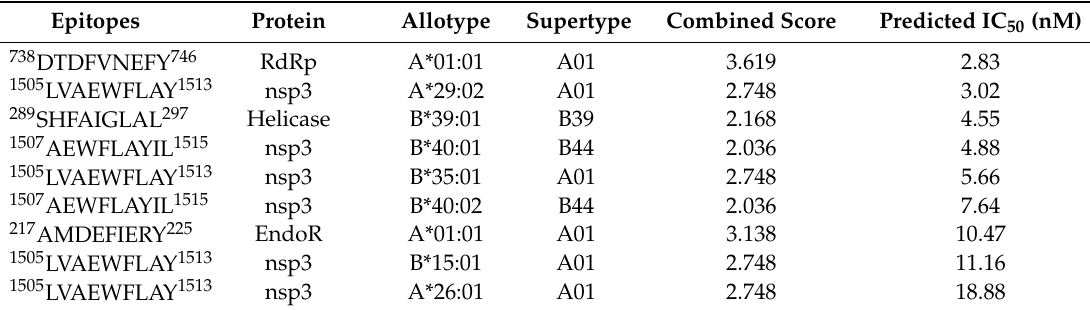
Figure 1. Prediction of binding of antiviral peptides to MHC-I allotypes. ( A ) Distributions of the predicted a ffi nities (IC 50 , log scale) to HLA-A and HLA-B supertypes of all possible linear 8- to 11-mer peptides derived from the 26 proteins of the SARS-CoV-2 proteome. The predicted MHC class I binding epitopes were classified as strong MHC binders (IC 50 ≤ 50 nM), weak binders (50 nM < IC 50 ≤ 500 nM) and non-binders (IC 50 > 500 nM); ( B ) Number of MHC-I–binding 9- and 10-mers categorized as strong, weak and non-binders; ( C ) Number of 9-mer epitopes with an immunogenicity score ≥ 0.25 in SARS-CoV-2 proteins identified with the IEDB and NetCTL1.2 prediction methods. Table 2. Most potent SARS-CoV-2–derived MHC class I binding epitopes identified with both the IEDB (lowest IC 50 ) and NetCTL1.2 (highest combined score) in silico prediction methods.